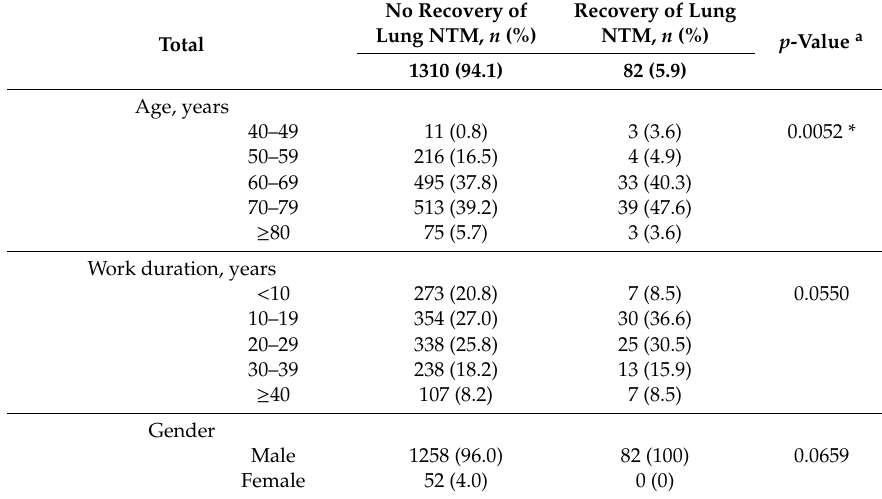
Table 1. Di ff erences between patients with and without NTM lung infection in terms of demographic, occupational, and radiological